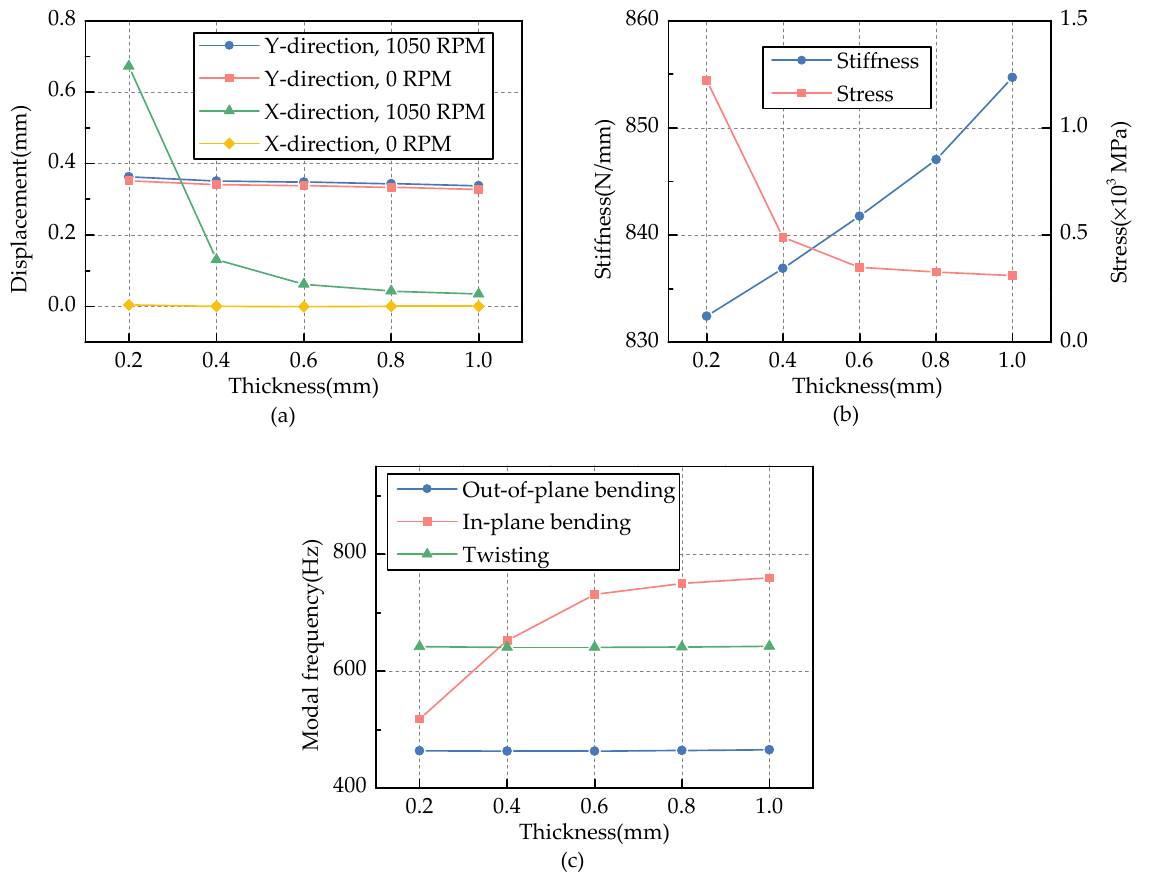
Figure 7. The influence of the flexible hinge thickness on the actuator performance: ( a ) Displacement of the actuator; ( b ) Stiffness and structural stress of the actuator; ( c ) Modal frequencies of the actua- tor.